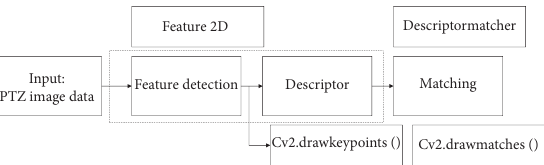
Figure 1: Template matching.